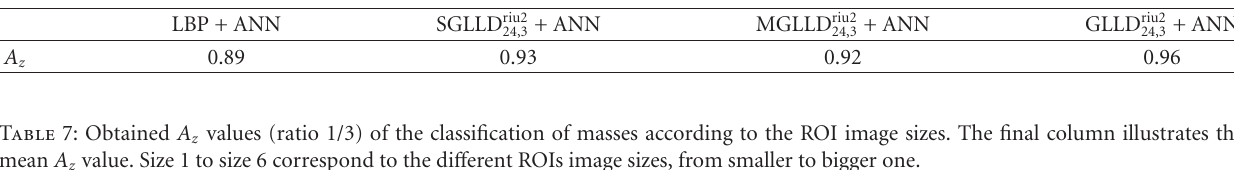
Table 6: A z for di ff erent existing local pattern-based features and the GLLD proposed one.